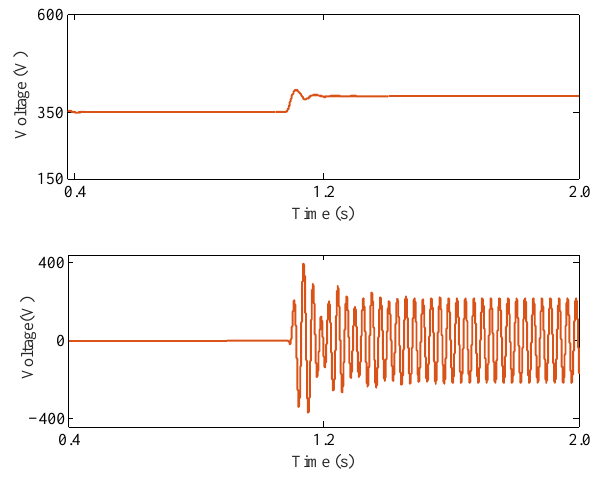
Figure 17. DC bus voltage ( top ) and supply to the grid ( bottom